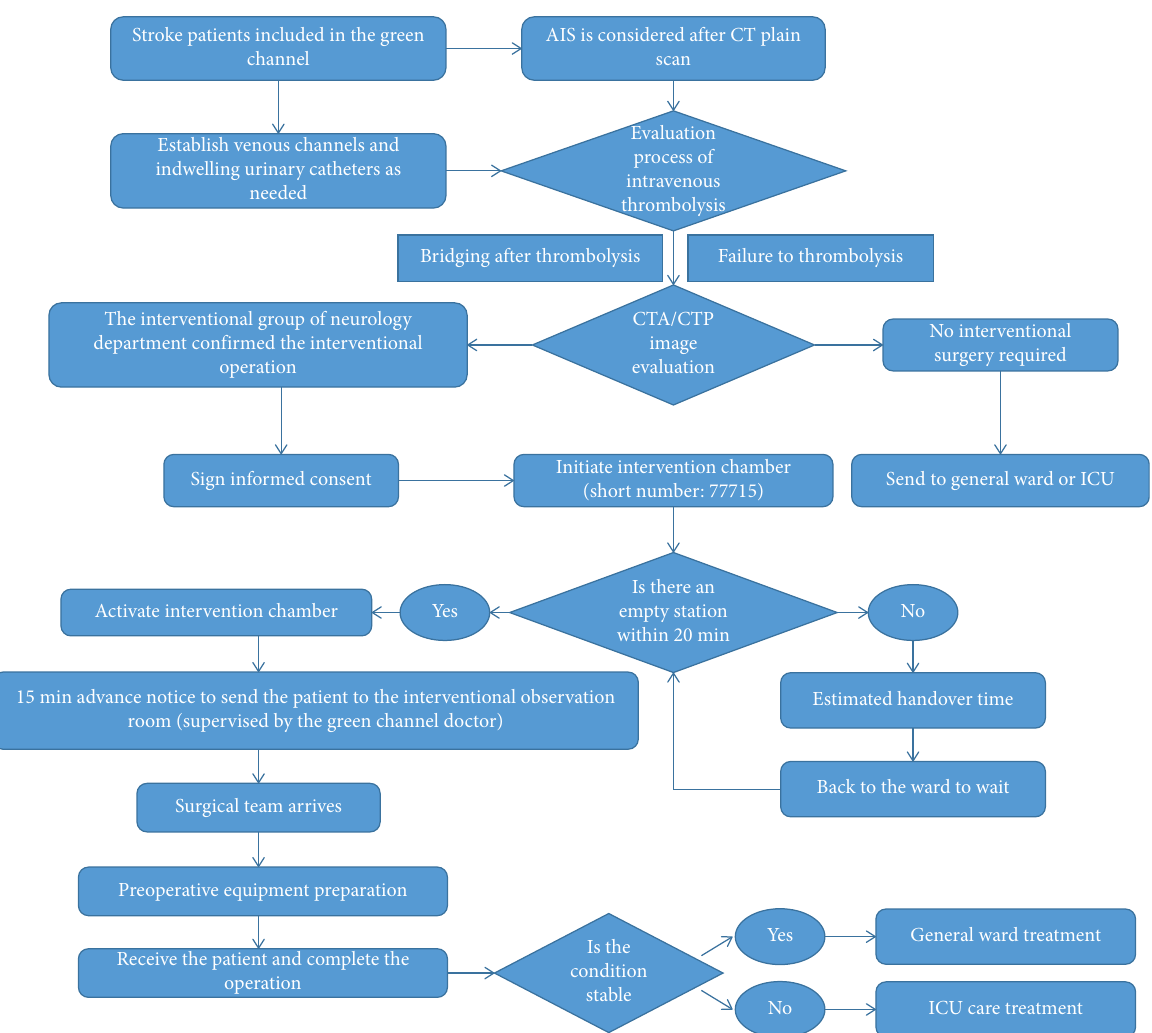
Figure 1: Flow chart of multidepartment linkage treatment for AIS patients with emergency interventional